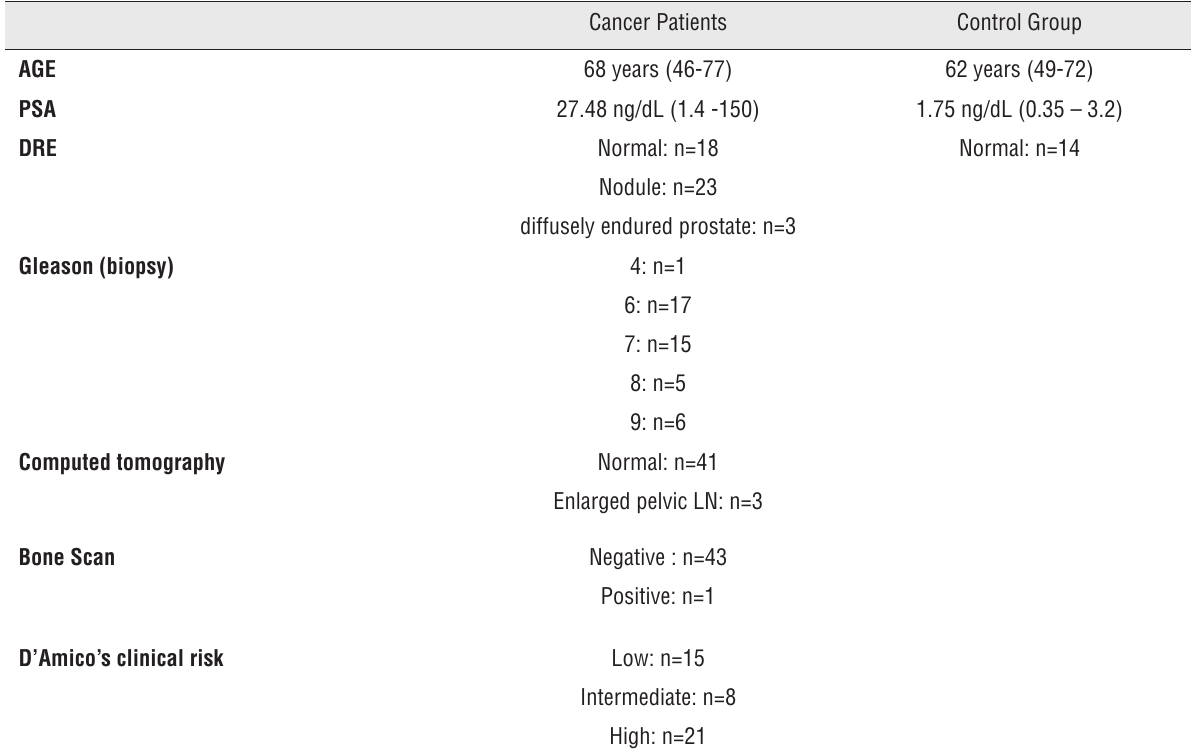
Table 1 - Clinical characteristics of cancer patients and control